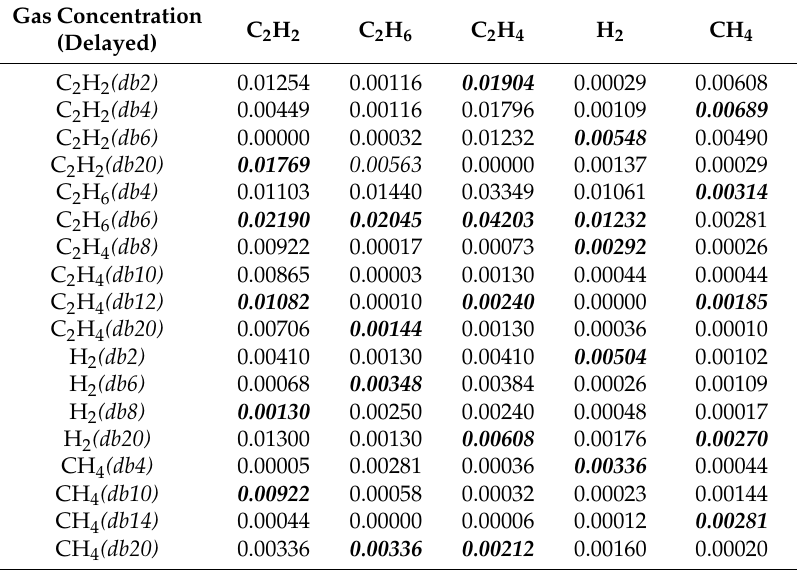
Table 6. Correlation level of time